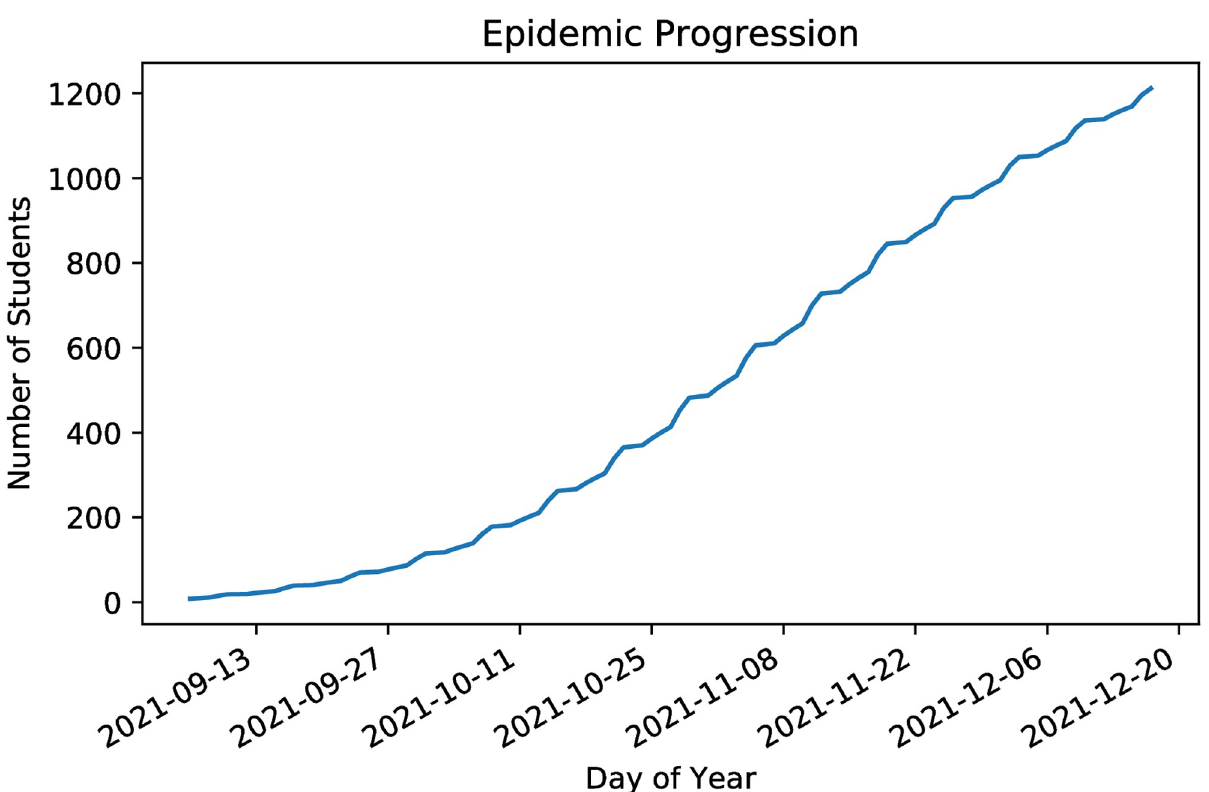
Fig 3. The number of infections over time in our base model with R 0 = 3 and no vaccination.